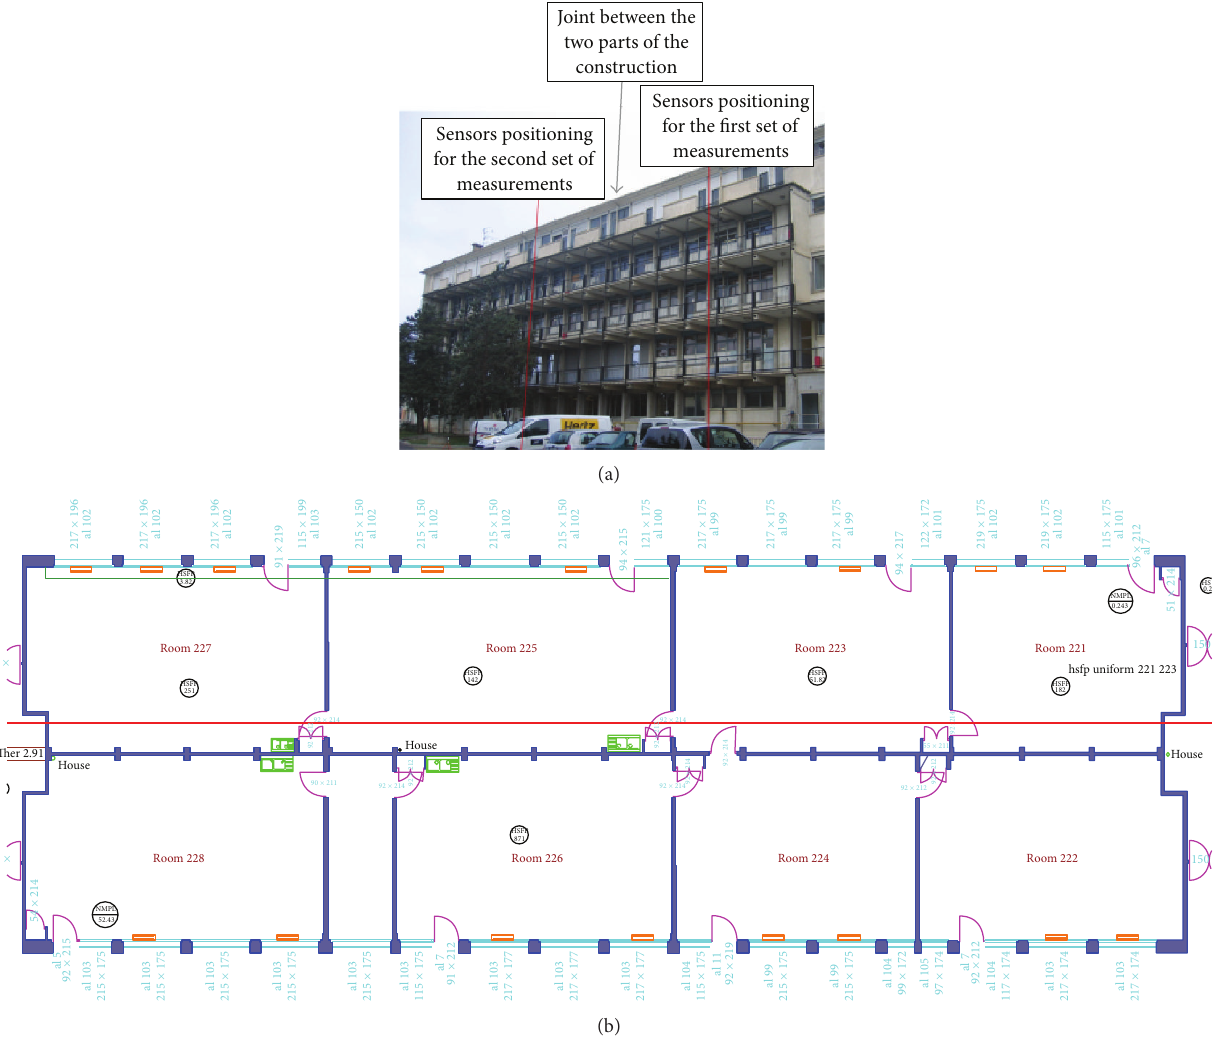
Figure 10: (a) 3D view and (b) plan view of Picasso